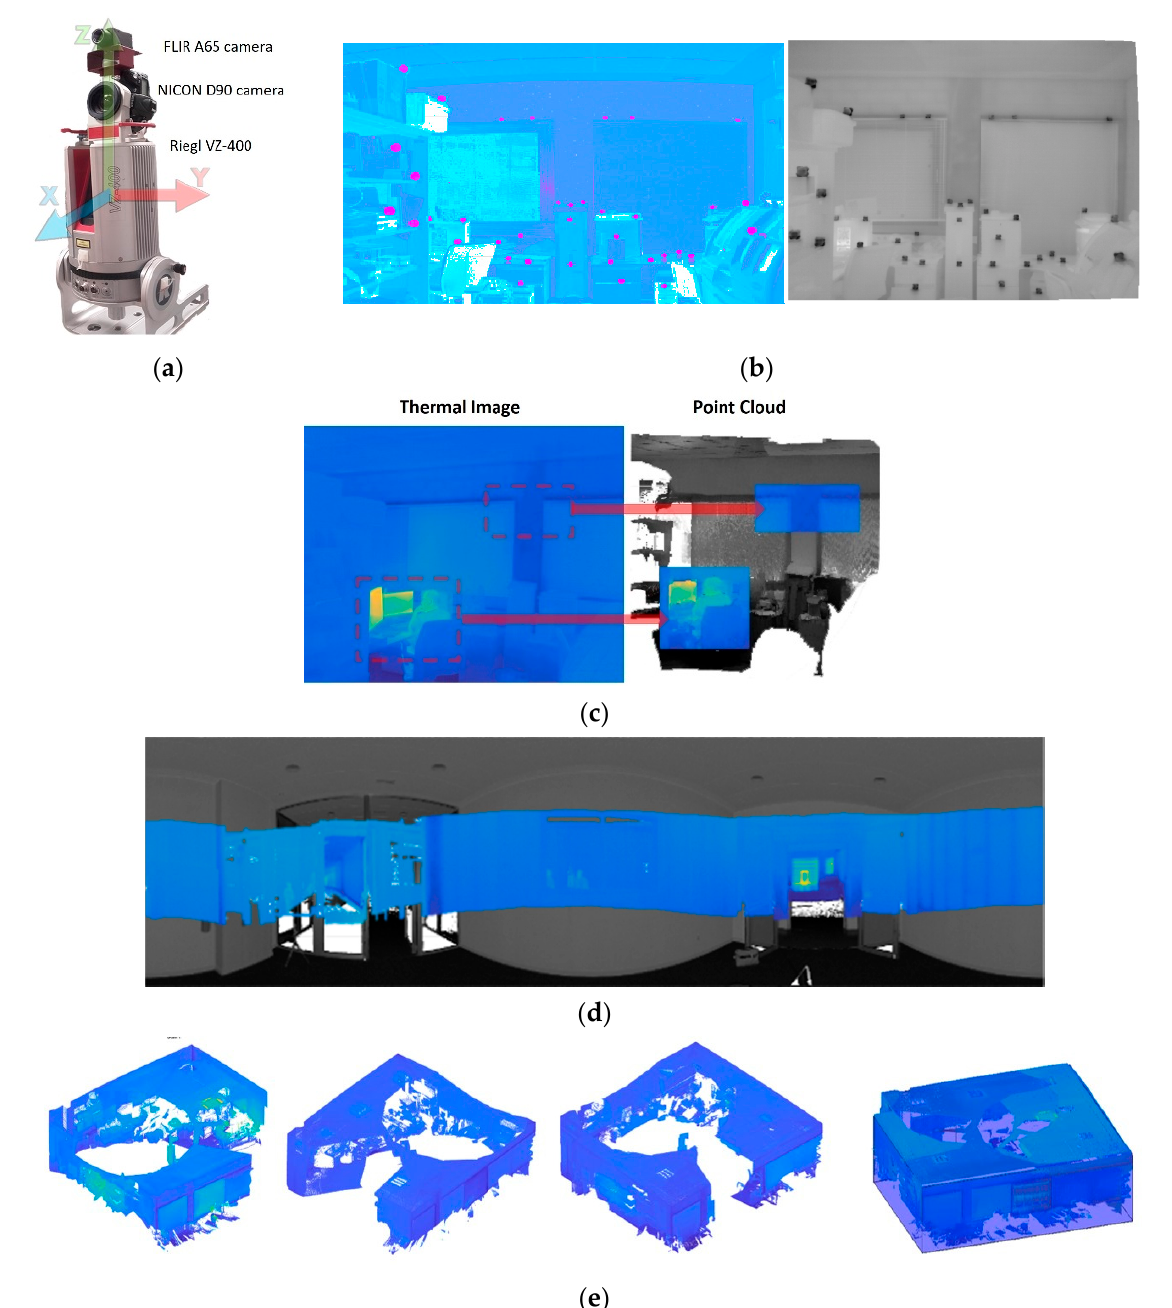
Figure 5. ( a ) Riegl 3D-VZ400 scanner coupled with a 65 A FLIR IR camera and RGB NICO D90 camera. ( b ) Highlighted targets in the point cloud (left) and in the thermal image (right). ( c ) An example of a 3D-thermal image. ( d ) An example of a 360° thermal scan visualised on a polar image. ( e ) Aligning three 360° thermal scans and obtaining a single-subsampled thermal point cloud.